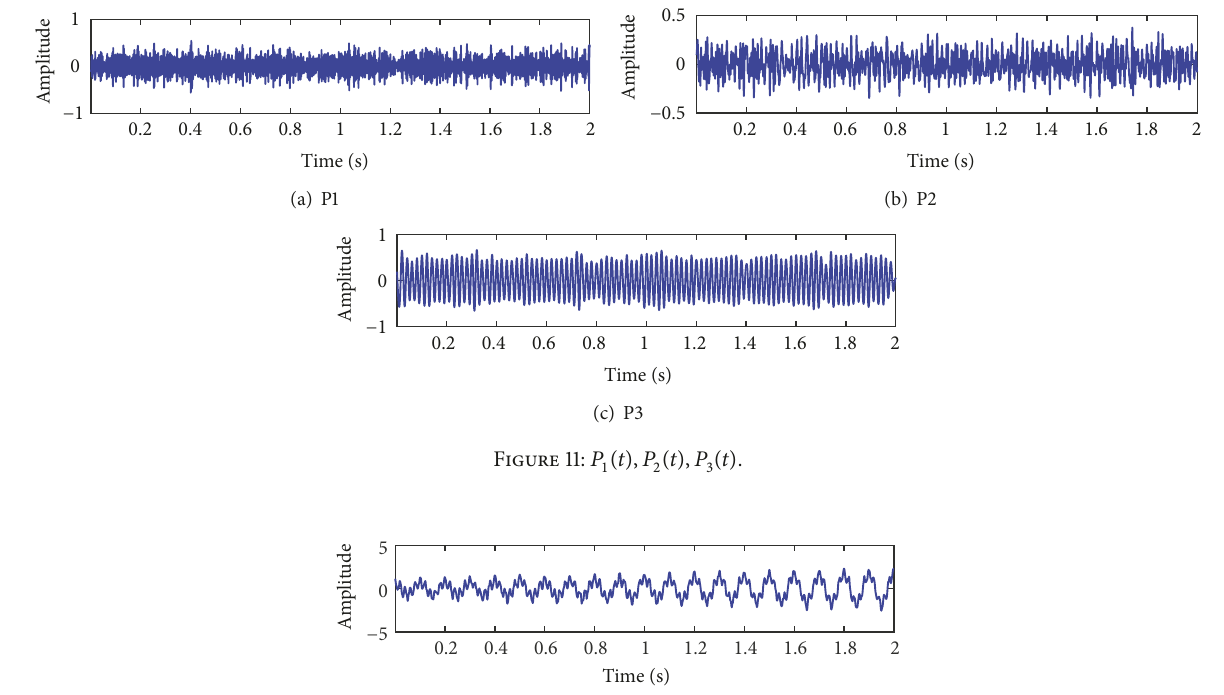
Figure 12: Time-domain waveform of the signal after removing the abnormal